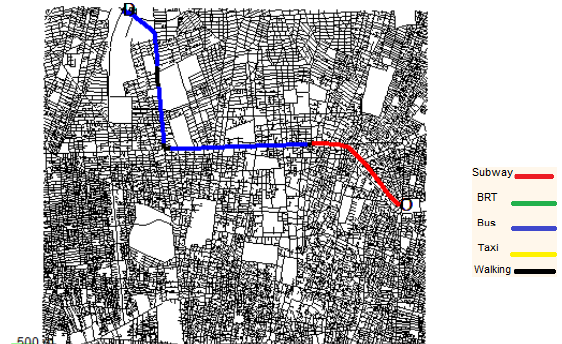
Figure 12. An example of the obtained optimal route according to the weights shown in Figure7 (Length: 8620.2 m, Time=41.8